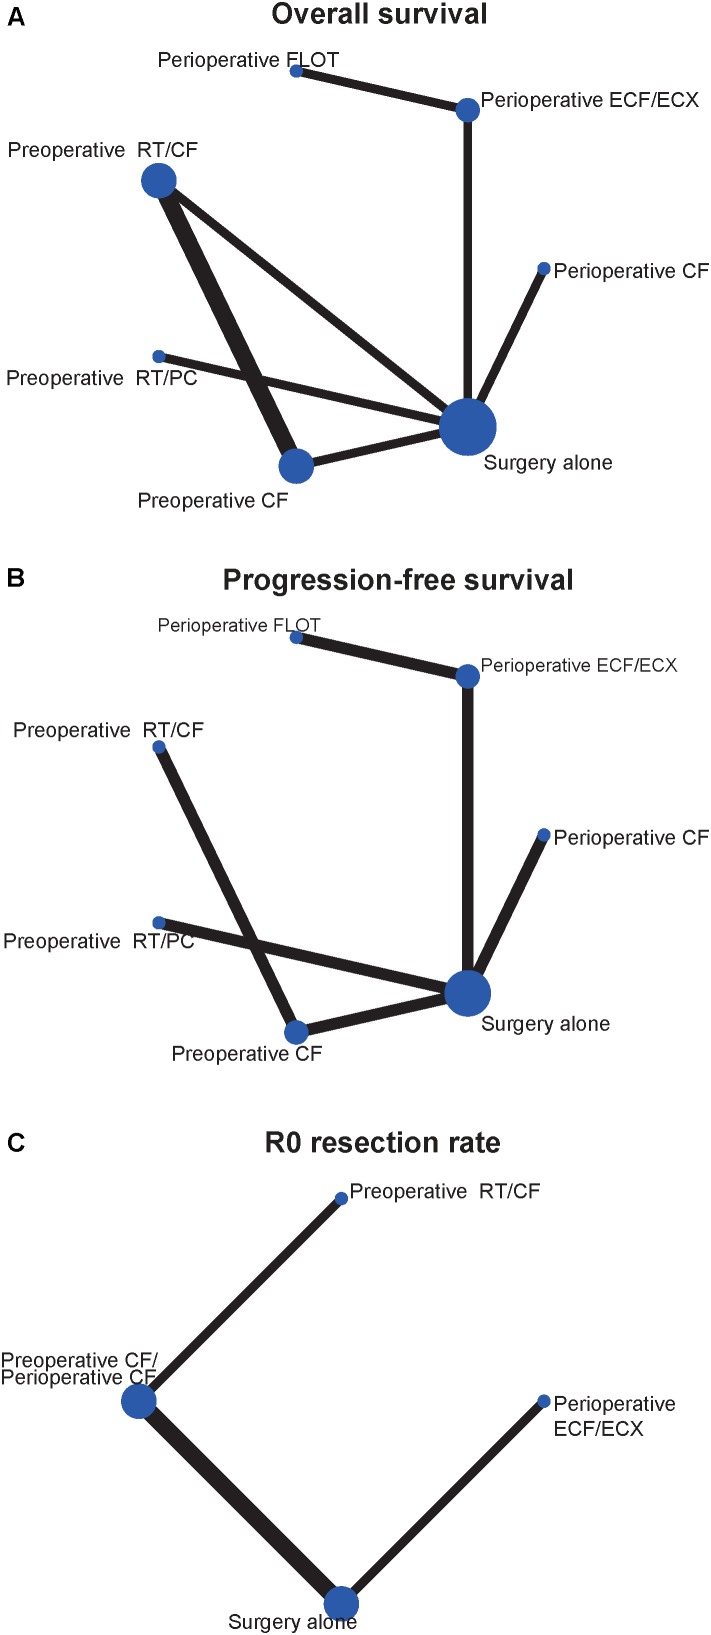
Network of the comparisons for the Bayesian network meta-analysis. (A) Overall survival; (B) progression-free survival; (C) R0 resection rate. The size of the nodes and the thickness of the edges are weighted according to the number of studies evaluating each treatment and direct comparison, respectively.